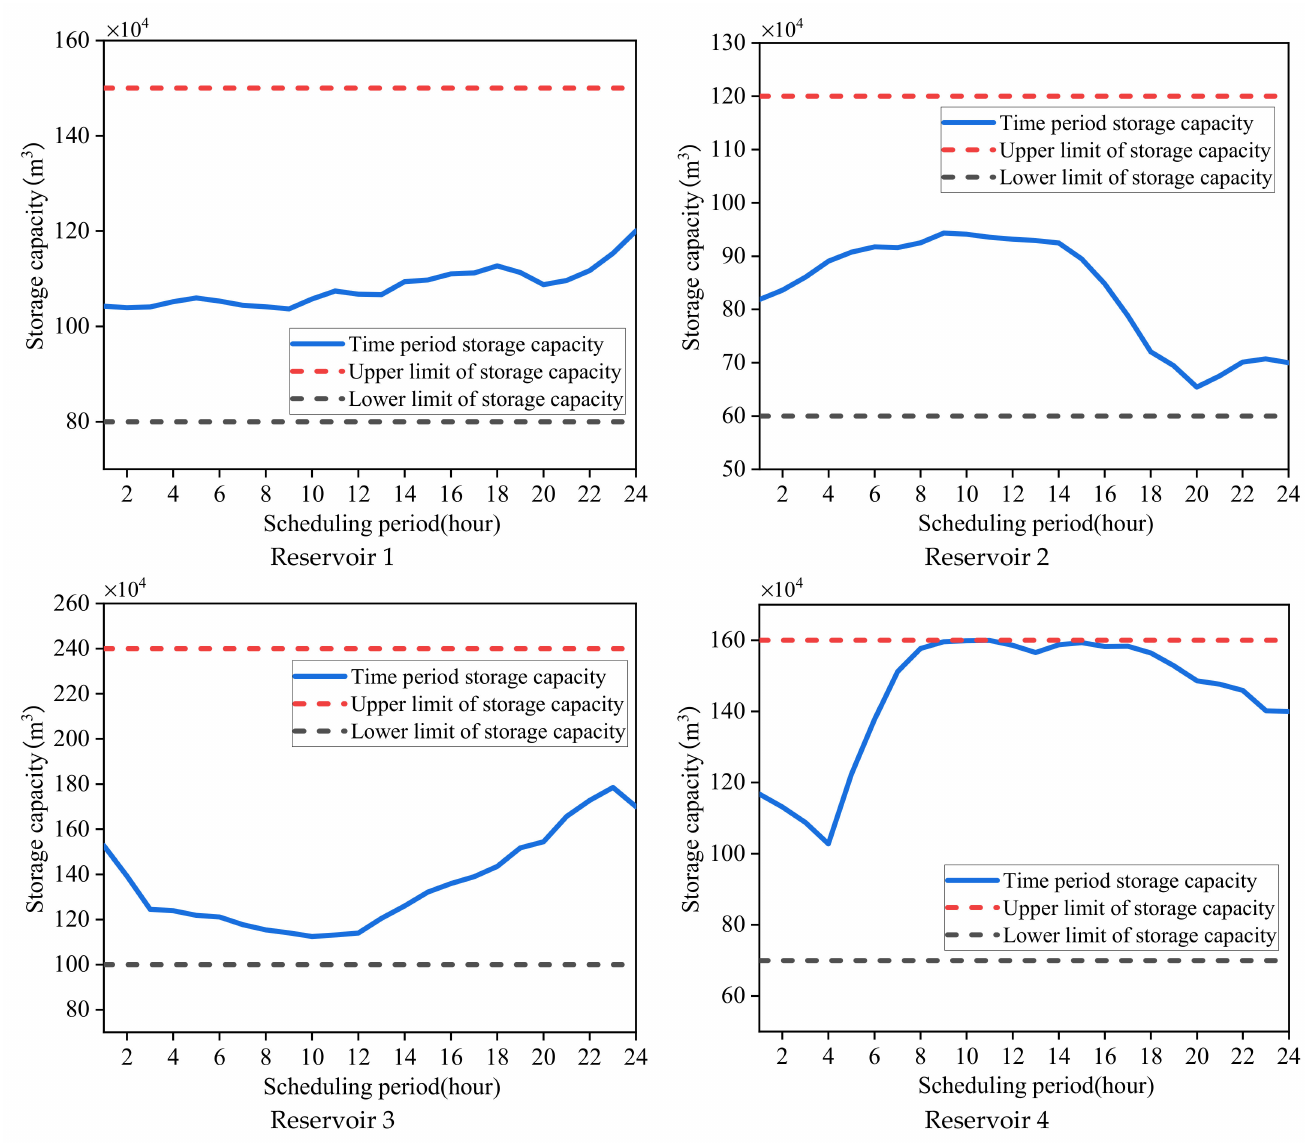
Figure 8. Optimized scheduling process of storage capacity by